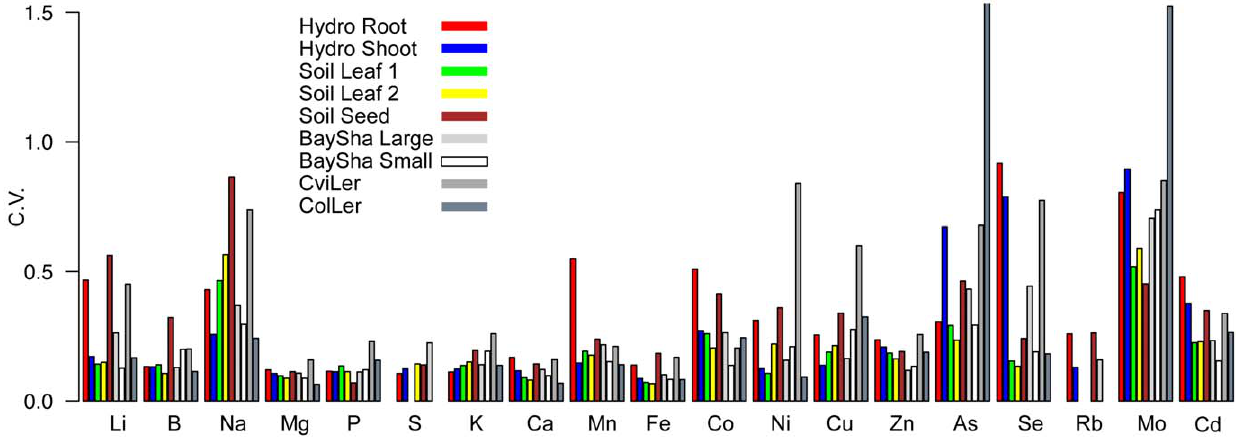
Figure 1. Coefficiant of variation (C.V., standard deviation(line averages)/mean( line averages)). BaySha Large, BaySha Small, CviLer and ColLer are RIL populations analyzed in [24].